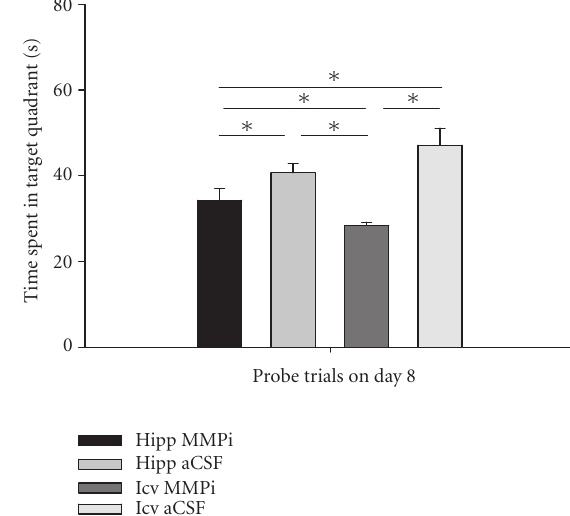
Figure 3: Mean SEM time spent by members of each group in (cid:0) the target quadrant during one 120-second probe trial (platform removed) following acquisition training on day 8 in the Morris wa- ter maze. Bilateral injection of an MMPi into dorsal hippocampi or icv significantly reduced time spent in the target quadrant as com- pared with bilateral injection of aCSF. Those animals icv injected with MMPi revealed the least time spent in the target quadrant 0 . 8 seconds) followed by those injected with MMPi into the (28 . 4 (cid:0) 2 . 7 seconds). Those groups injected with dorsal hippocampi (34 . 3 (cid:0) the aCSF into the dorsal hippocampi or icv displayed significantly 2 . 2 and 47 . 1 4 . 0s, resp.). (cid:0) P < . greater spent time (40 . 7 (cid:0) (cid:0)